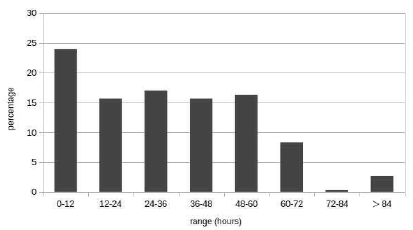
Figure 7. Distribution of the temporal gap between the closest (S1, S2) images from the available images.